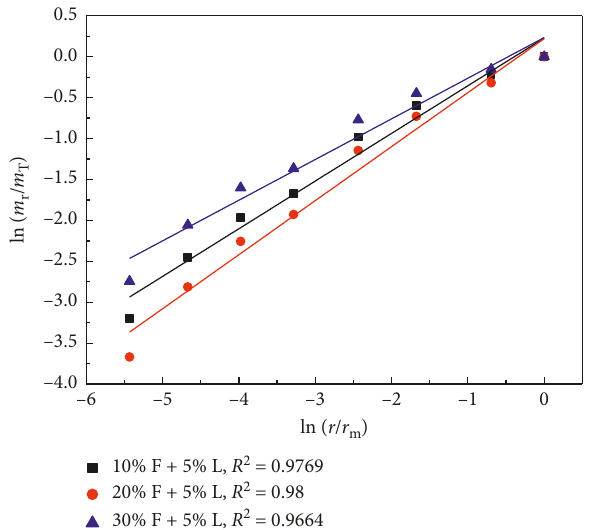
Figure 10: The ln [ m